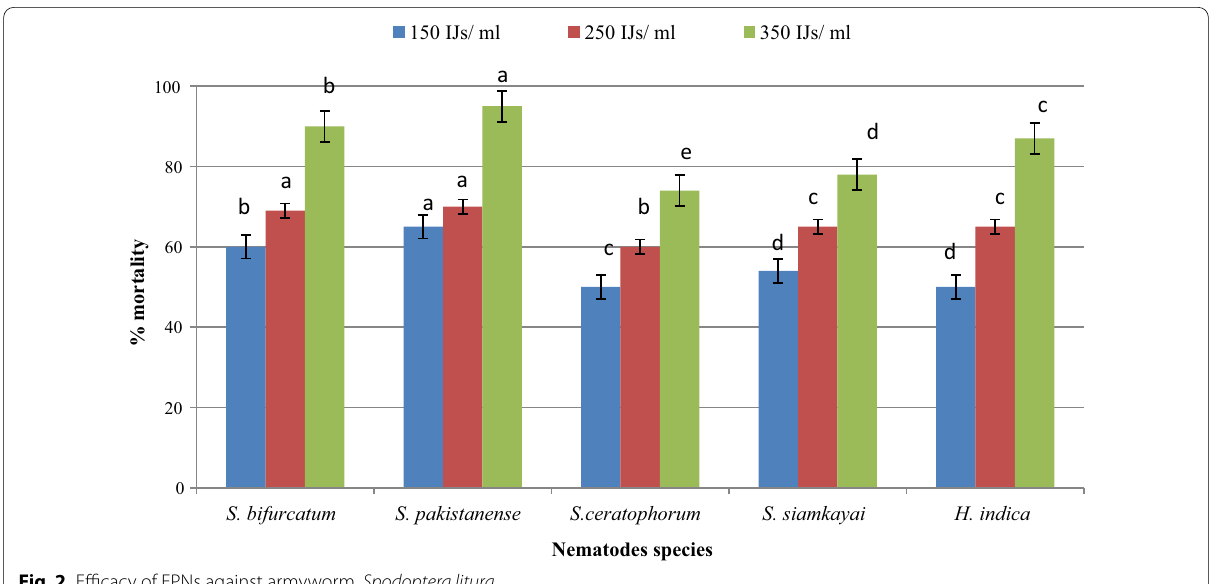
Fig. 2 Efficacy of EPNs against armyworm, Spodoptera